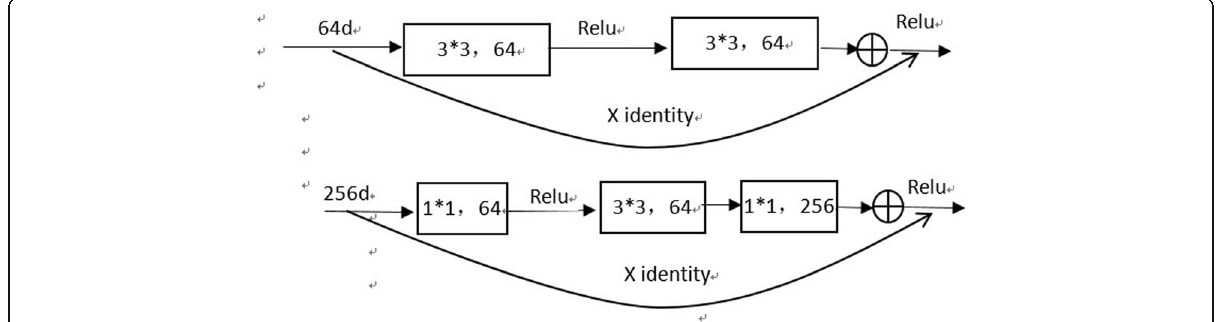
Fig. 6 Two-layer and three-layer residual learning